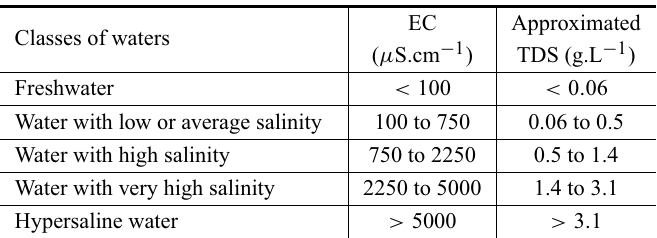
Classification by EC ( μ S.cm − 1 ) adopted for the lake waters studied and the approximate content of total dissolved solids (TDS) calculated by the mean value reported in APHA